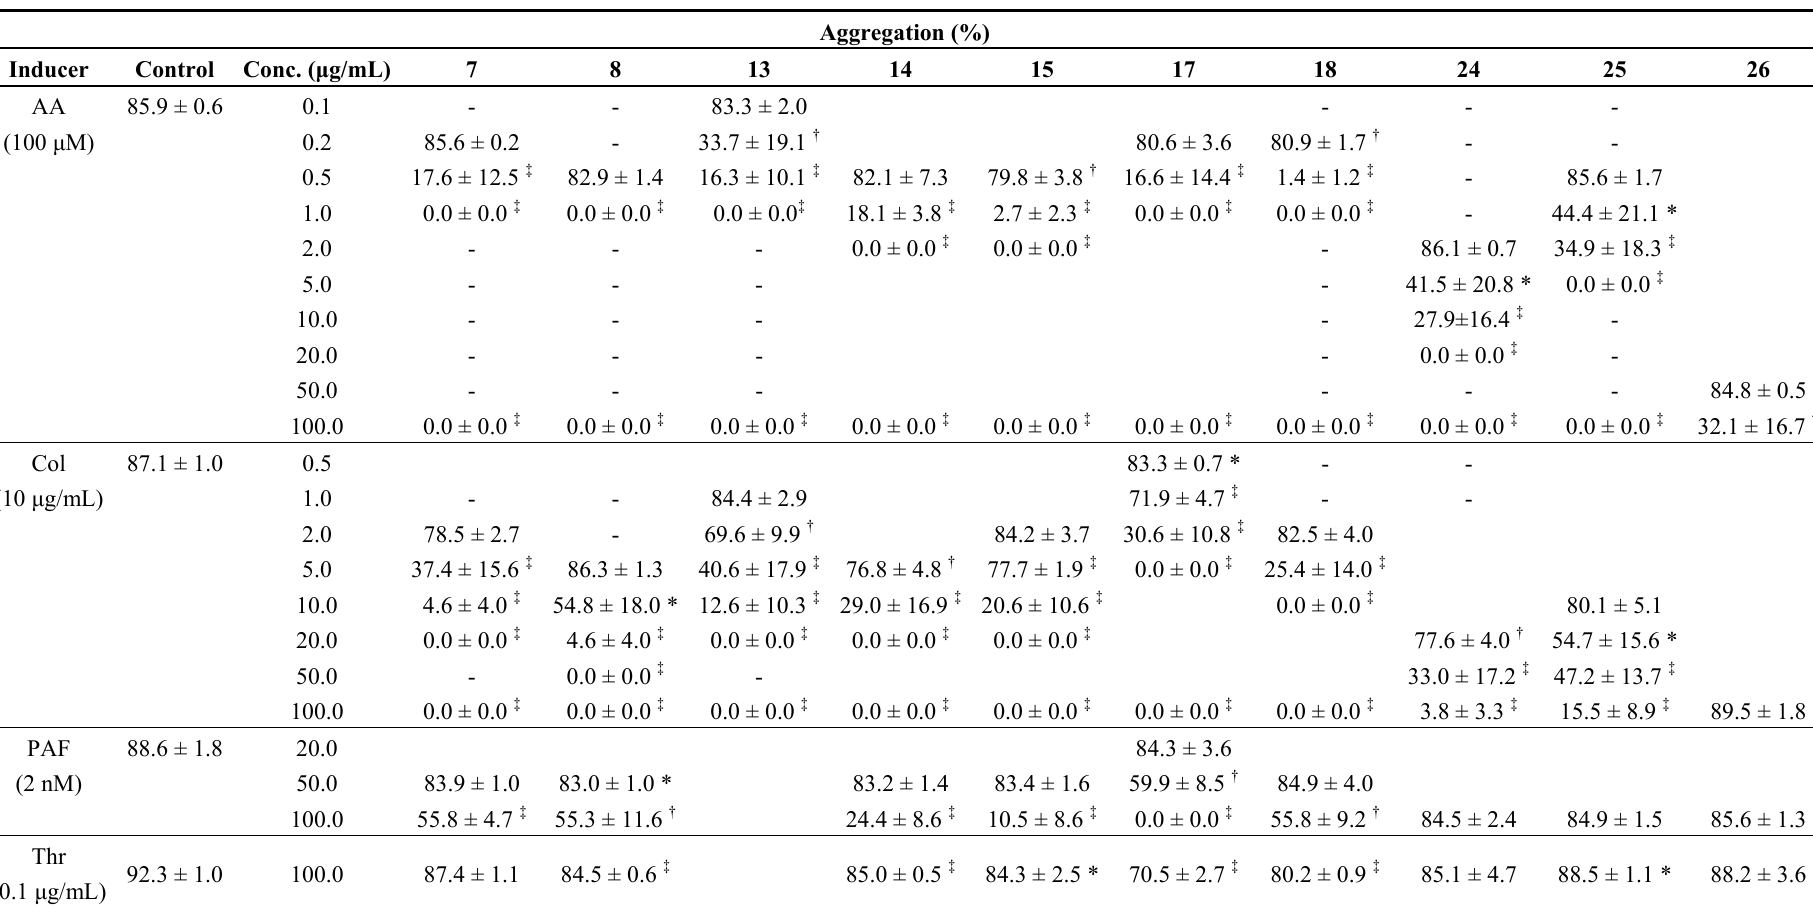
Table 1. Effects of compounds 7 , 8 , 13 – 15 , 17 , 18 , 24 – 26 on the aggregation of washed rabbit platelets induced by arachidonic acid (AA), collagen (Col), PAF and thrombin